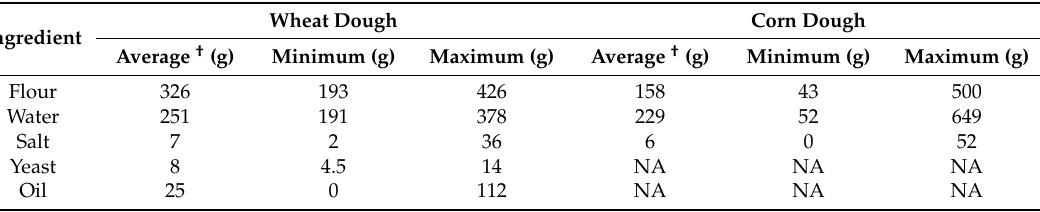
Table 5. Amount of each of the ingredients (g) used by 43 wheat dough preparers and 50 corn dough preparers during the dough preparation